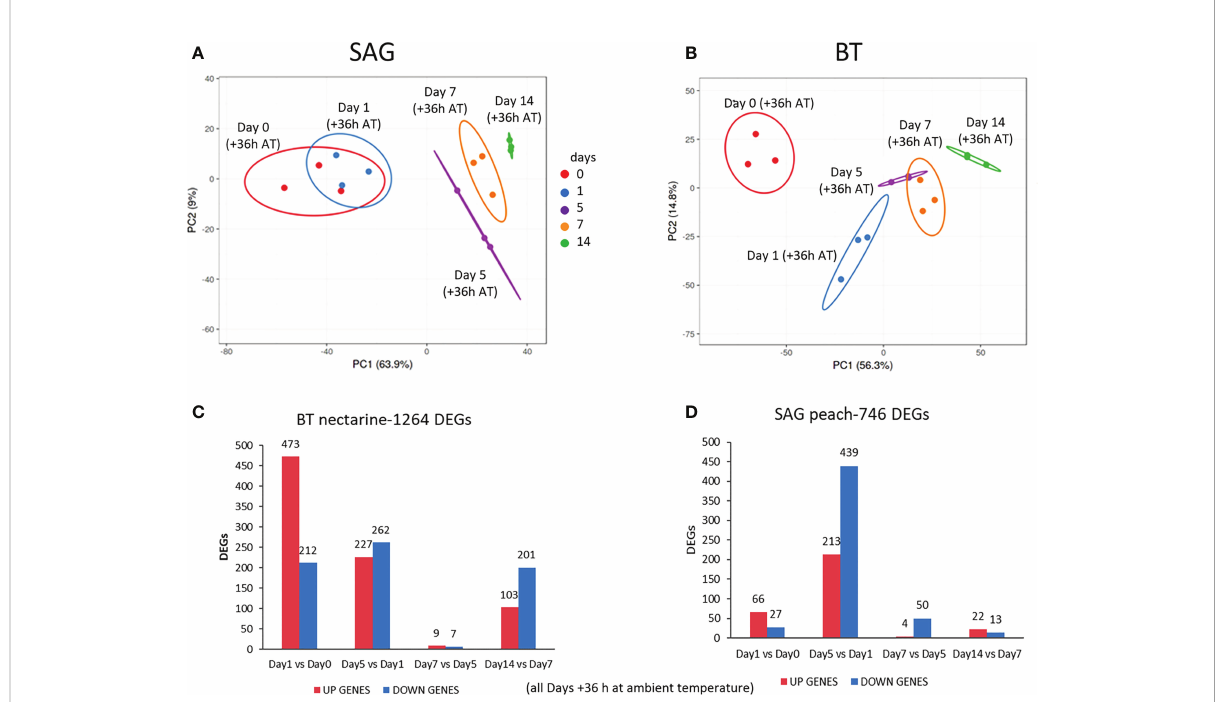
FIGURE 2 Gene expression changes during cold storage. Principal Component Analysis (PCA) of normalised raw gene expression counts in SAG peach (A) and BT nectarine (B) for each day of cold storage at 1 °C (+36 h at ambient temperature (AT) 22 °C). Differentially expressed genes (DEGs) among successive storage time points for each cultivar: Sagittaria (SAG) peach (C) and Big Top (BT) nectarine (D) . Gene expression level values were normalized by the DESEQ2 software (pvalue corrected < 0.05 andlog2FC> 1.5).